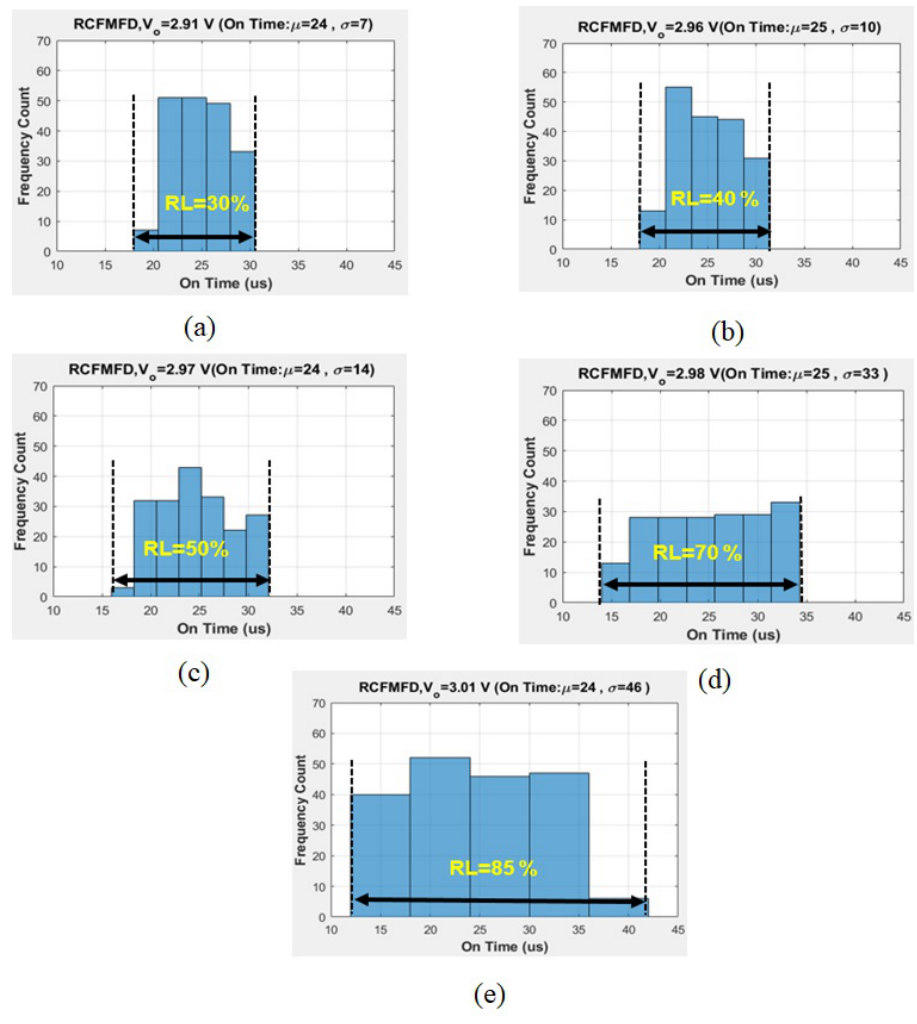
Figure 16. Comparison of histograms of switching signals for various randomness levels (RL) of